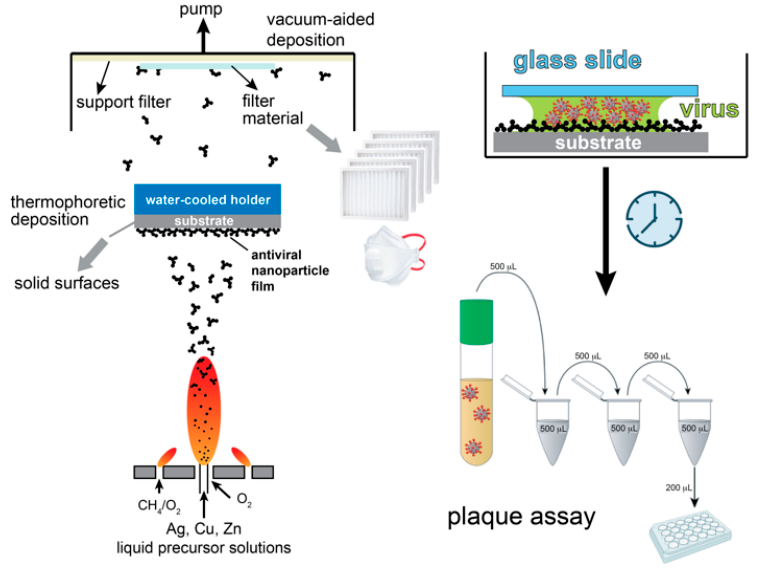
Figure 1. Schematic of the flame aerosol deposition process of antiviral nanoparticle coatings on solid flat substrates as well as on porous filter materials. The as-prepared nanoparticle coatings are then incubated with SARS-CoV-2, and their antiviral activity is examined by the plaque